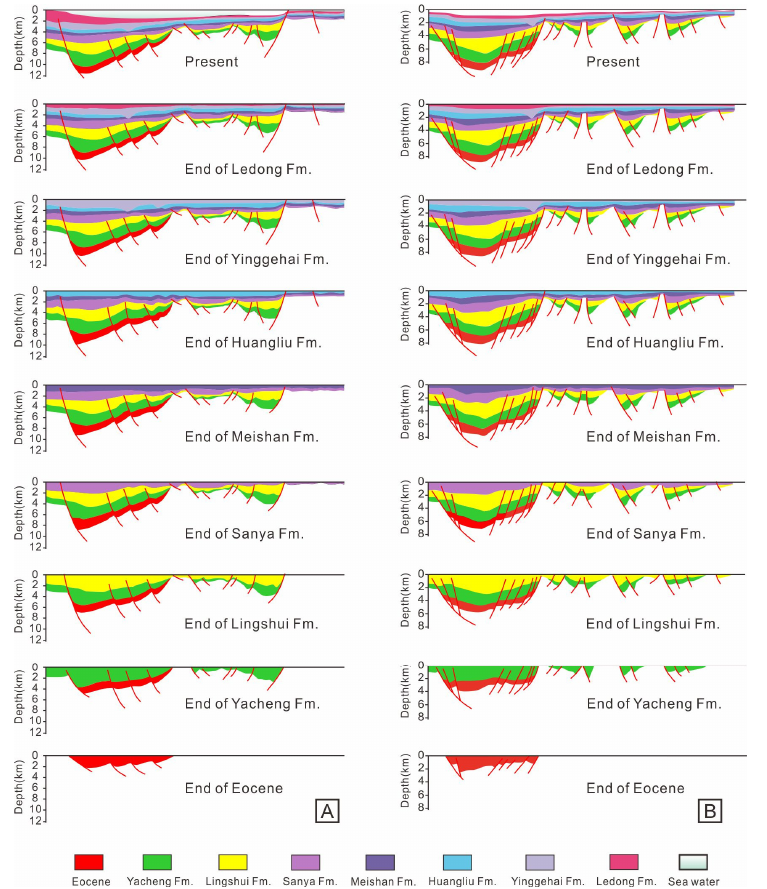
Figure 8. ( A , B ) Balanced cross-sections created based on the two profiles traversing the Lingshui and the Baodao Sag, respectively (for location, see Figure 1).